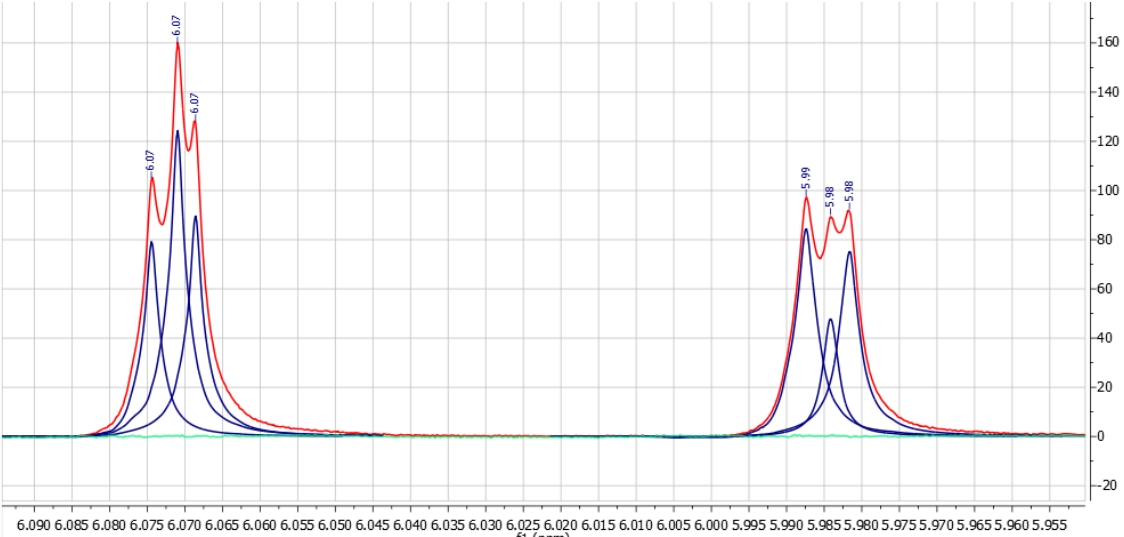
Figure 3. 1 H-NMR spectral deconvolution (GSD) of peaks corresponding to sites C(6) (6.07 ppm) and C(8) (5.98 ppm). 1 H-NMR spectrum taken at t ~ 500 min from 4a kinetics experiment at T = 305 K. Red, blue, and green curves represent the experimental 1 H-NMR, deconvoluted peaks, and residuals, respectively.